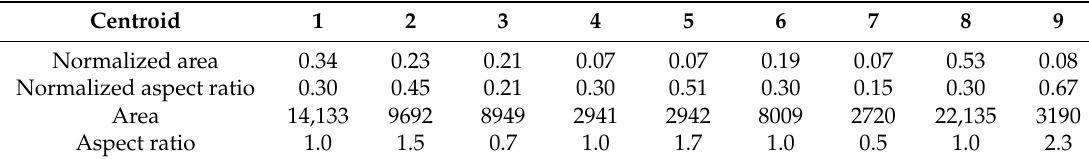
Table 1. Centroid table after area aspect ratio clustering.